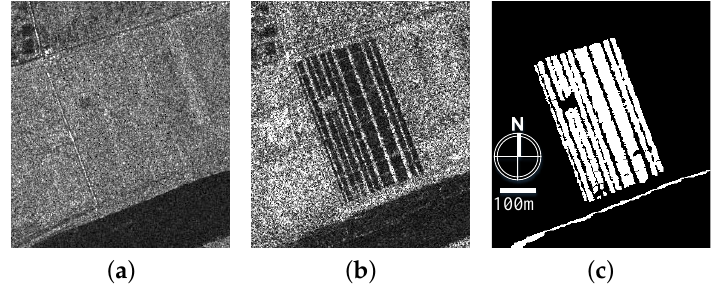
Figure 10. The Yellow River dataset: ( a ) the SAR image acquired in June 2008, ( b ) the SAR image acquired in June 2009, and ( c ) the reference image.